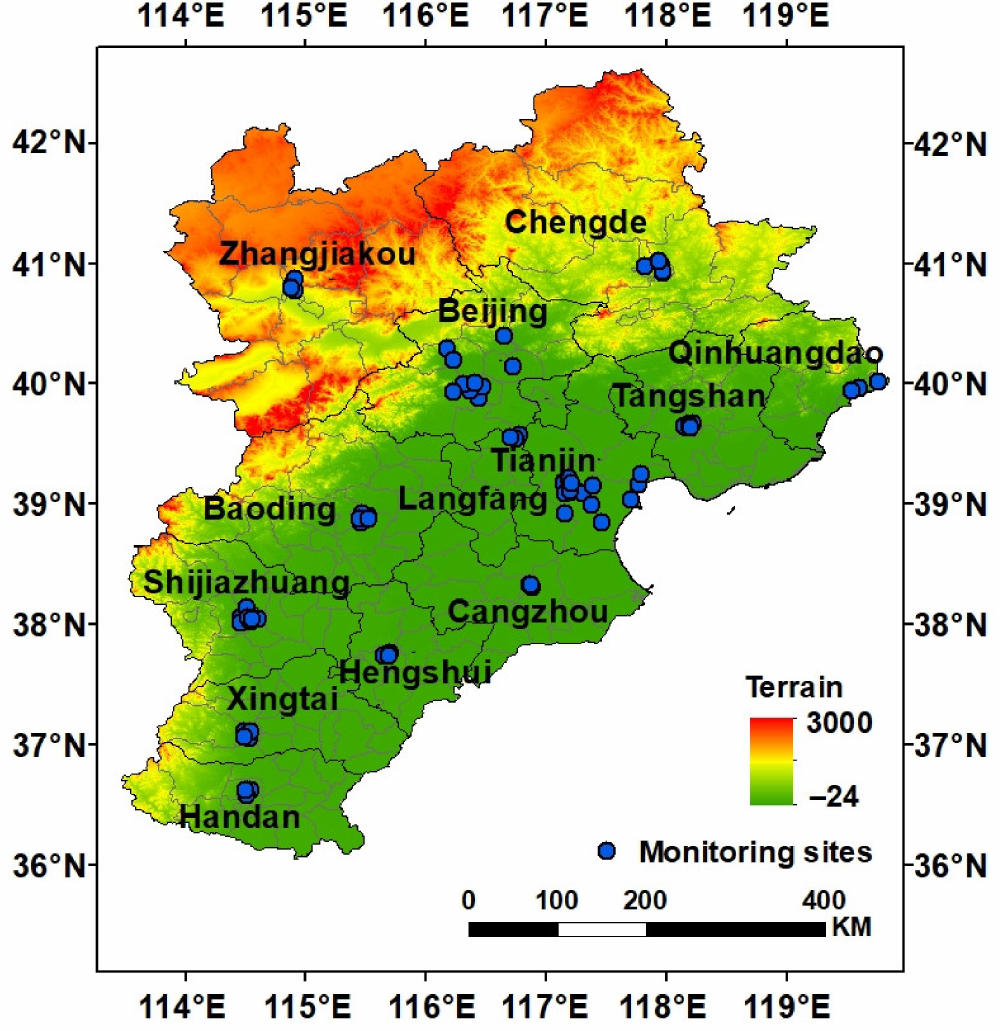
Figure 1. Distribution of O 3 monitoring stations in the BTH region atop a digital elevation model (DEM) of the